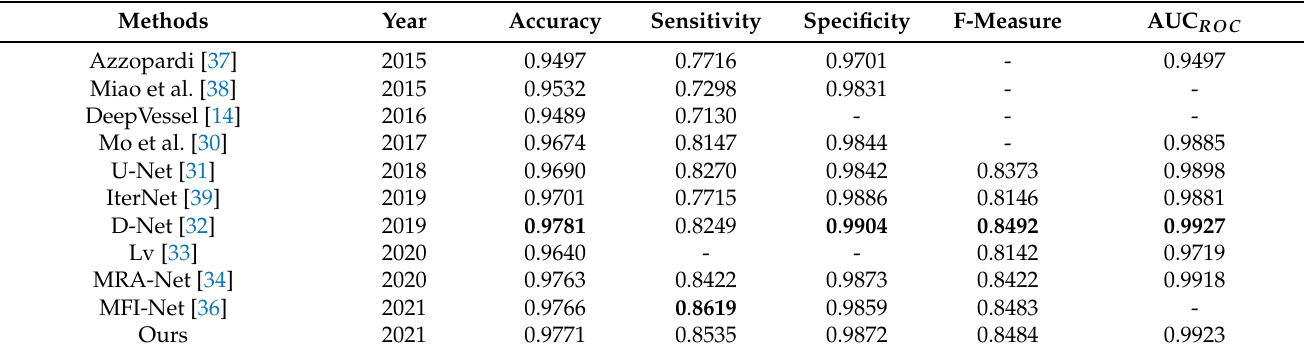
Table 5. Comparison of proposed methods with other methods on the STARE